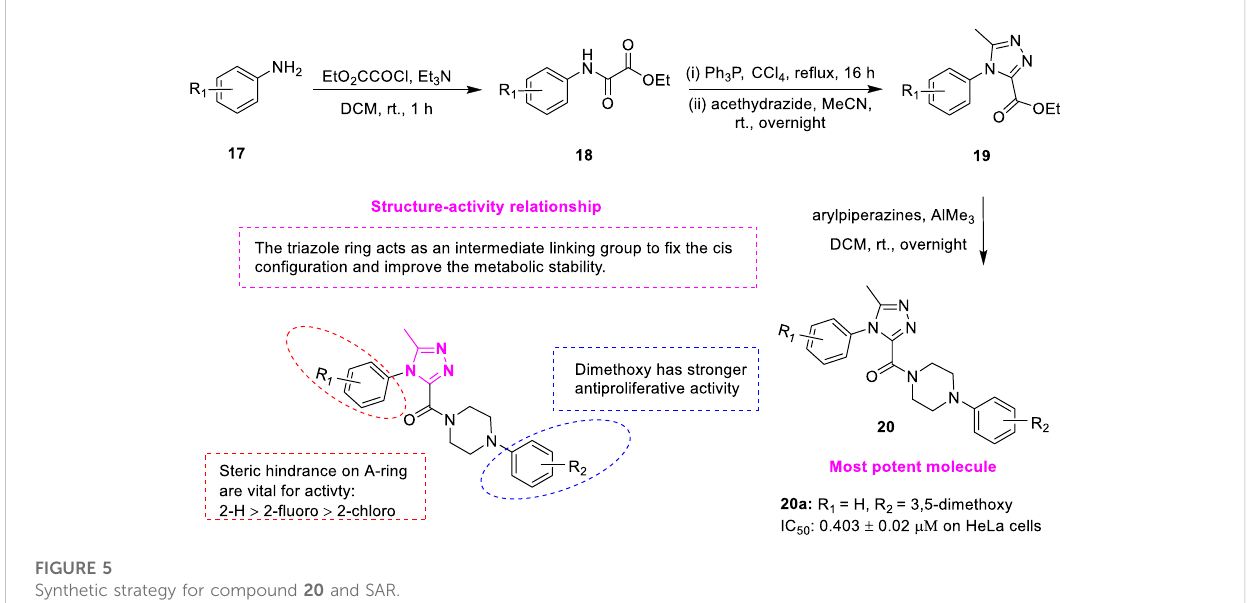
FIGURE 5 Synthetic strategy for compound 20 and